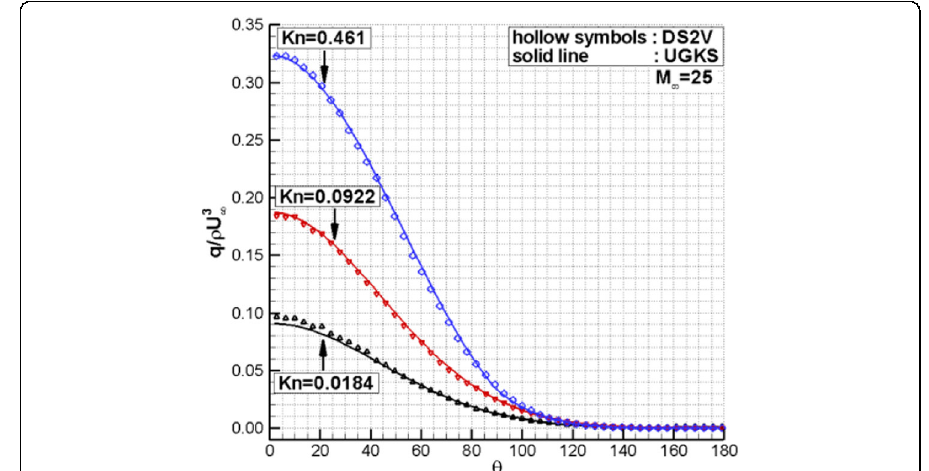
Fig. 21 Heat flux distributions on the cylinder surface at M =